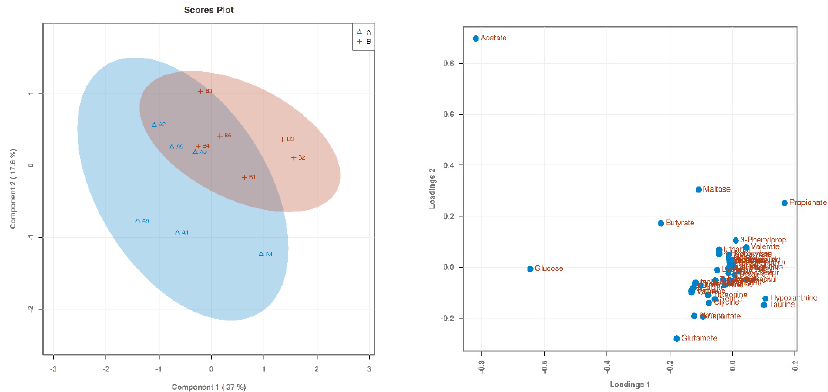
Figure 1. The score plot and loading plot of THR85 and THR100 from the partial least squares discrimination analysis (PLS-DA) analysis. In the above PLS-DA score chart, different groups are represented by different colors. The degree of dispersion can reflect the reproducibility of the samples and the similarity of the metabolic profiles among the sample groups. The comparison group tended to separate from each other, but the trend was not significant.